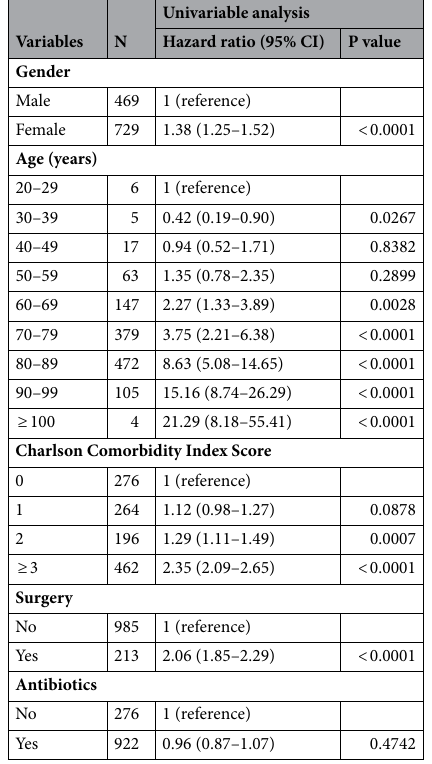
Table 3. Cox proportional hazard models of in-hospital mortality by